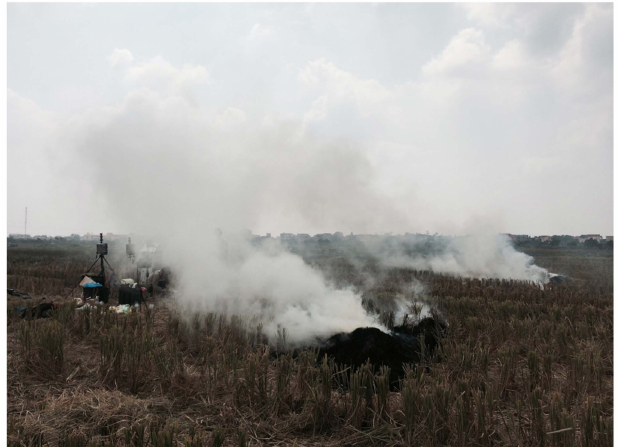
Figure 1. Field experiment for open burning of rice straw